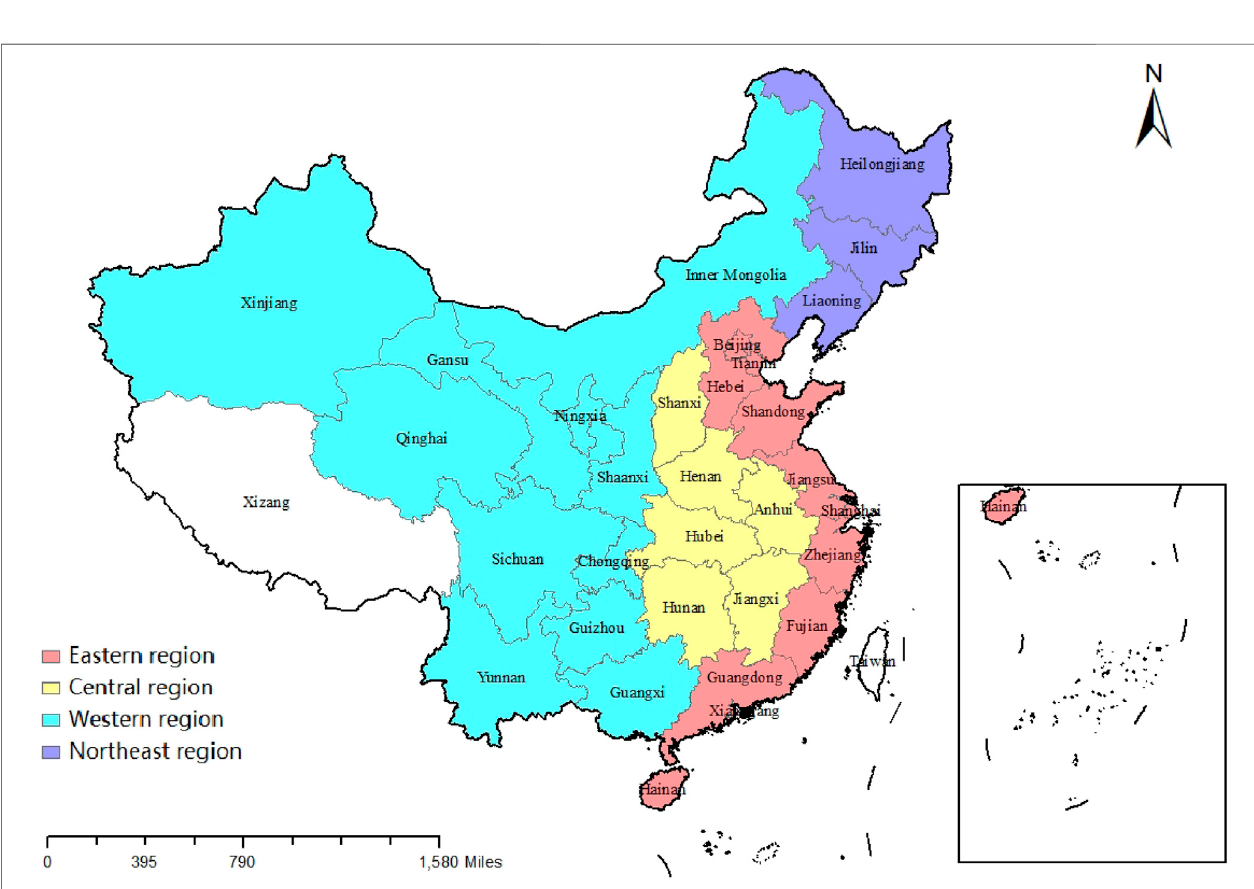
FIGURE 2 | Distribution of the four regions in